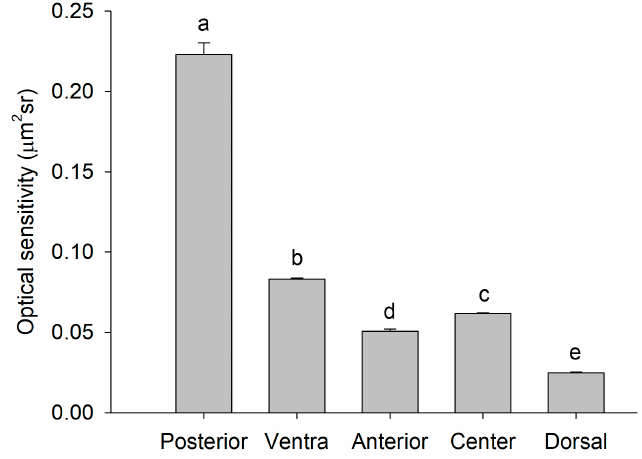
Figure 5. The optical sensitivity ( S ) in the posterior, ventral, anterior, central, and dorsal regions of female Empoasca onukii compound eyes (mean ± SE). The S value was calculated from Equation (1). The different letters indicate significant differences ( p < 0.05, one-way ANOVA).